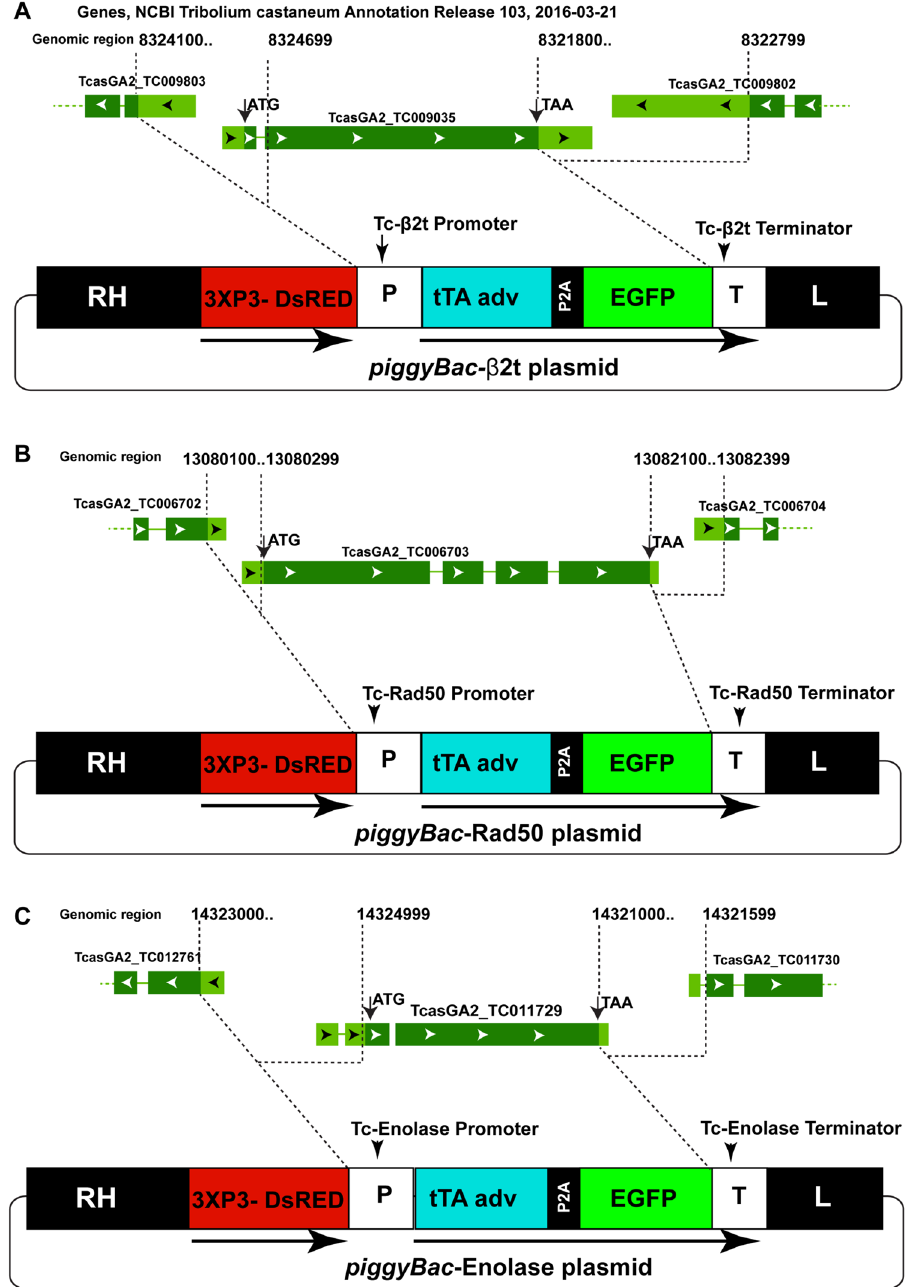
Figure 2. Schematic diagram of Tc-β 2 t , Tc-rad50 and Tc-eno loci and corresponding transformation constructs. Schematic diagrams of the Tc-β 2 t genomic locus and piggyBac -β 2 t donor plasmid ( A ), the Tc-rad50 locus and piggyBac -Rad50 donor plasmid ( B ), and the Tc-eno locus and piggyBac -Eno donor plasmid ( C ). All three constructs contained the 3XP3-DsRED cassette as a visual marker and piggyBac inverted repeats (RH and L) for transposase mediated integration in T. castaneum genome. tTA adv and EGFP were separated by the P2A site in all tested plasmids. P, putative promoter region; T, putative terminator region. Dotted lines indicate the upstream and downstream genomic regions used as promoter and terminator respectively to drive the tTA-P2A- EGFP expression in vector